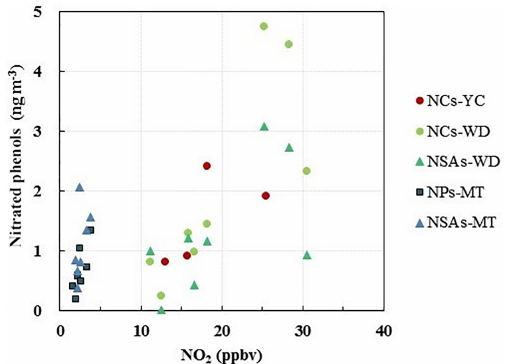
Figure 8. Scatter plot of nocturnal concentrations of nitrated phe- nols with NO 2 . NPs-MT and NSAs-MT indicate samples collected at Mt. Tai, NCs-WD and NSAs-WD samples were collected in Wangdu and NCs-YC samples were collected in